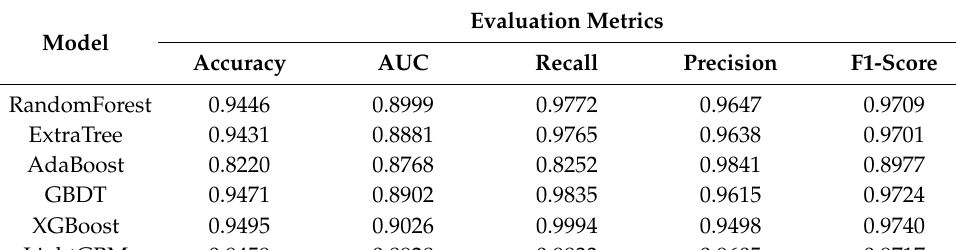
Table 10. Evaluation results on the ensemble learning model test set.